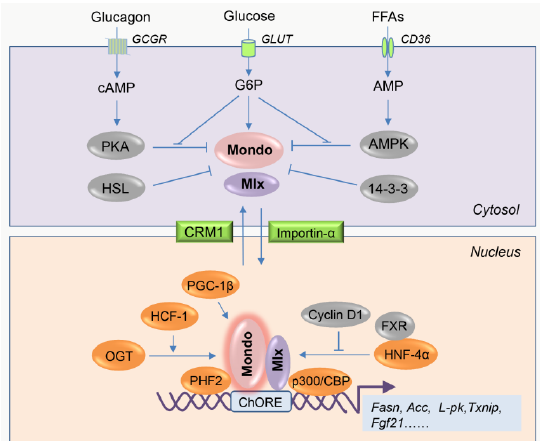
Figure 1. Regulation of MondoA / carbohydrate response element-binding protein (ChREBP) (Mondo) activity by nutrients and associated regulatory proteins. The activity of MondoA / ChREBP is dependent on its subcellular localization. Inactive state (upper panel): Under fasting conditions, intracellular cAMP and AMP activates protein kinase A (PKA) and AMP-activated protein kinase (AMPK)